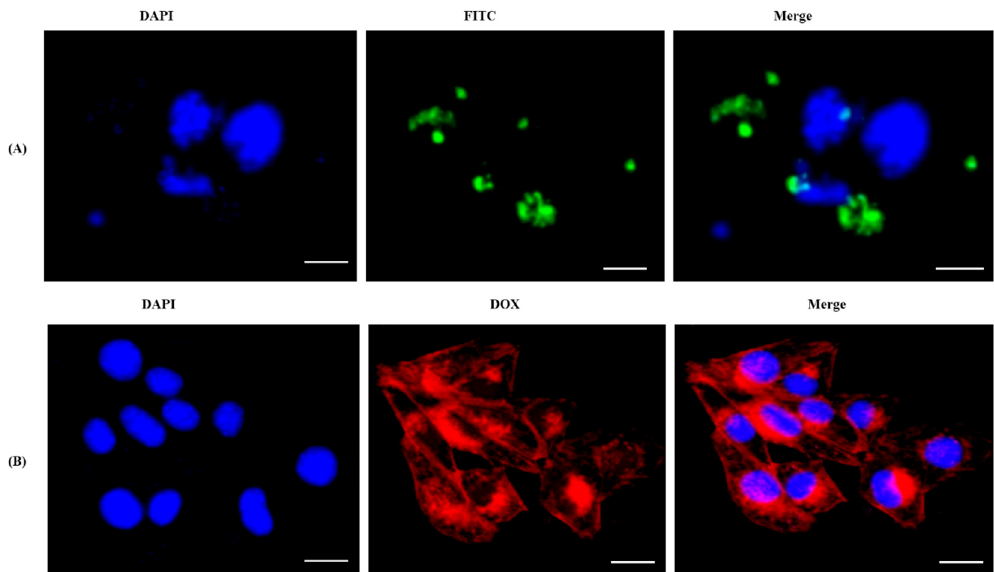
Figure 4. ( A ) Fluorescence microscopic images of CuAl-LDH (100 µ g/mL) cellular uptake with the treatment of FITC labeled CuAl-LDH (100 µ g/mL), and ( B ) intracellular DOX uptake in A549 cells treated with CuAl-LDH@DOX@PDA (20 × magnification), (Scale bar 100 µm).